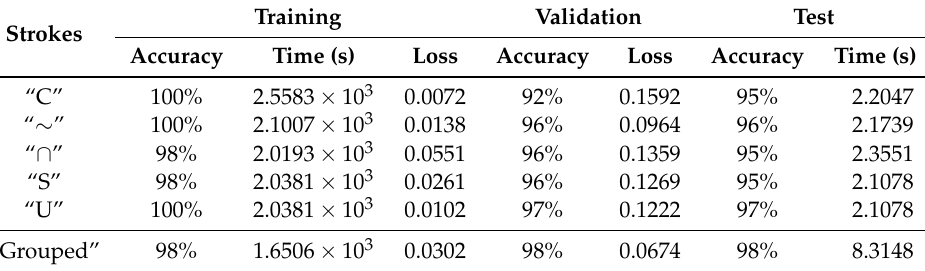
Figure 9. Simple Grapheme Resizing Process for Pretrained CNN Input. Table 8. Original Simple Grapheme - Alexnet (epoch = 50).